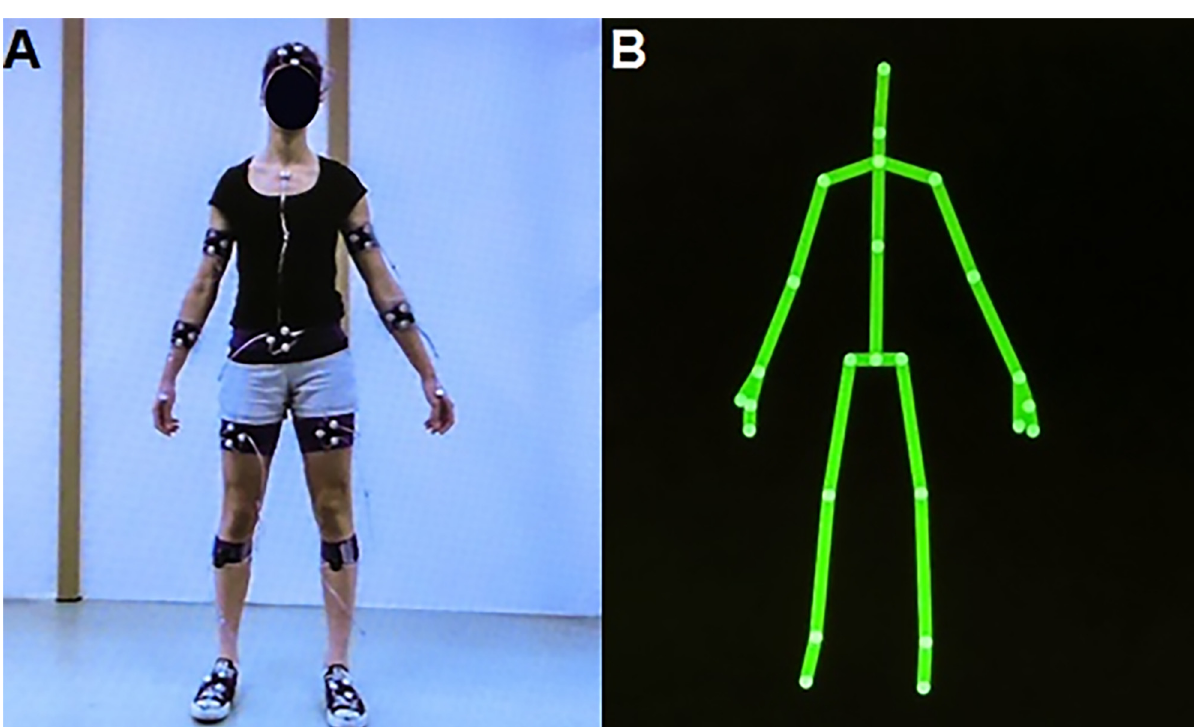
Fig 3. Body point determination with the Optotrak and Kinect v2 systems. (A) Subject with all markers of the Optotrak system; (B) Same subject with body points derived with the human-pose estimation algorithm of Kinect v2.